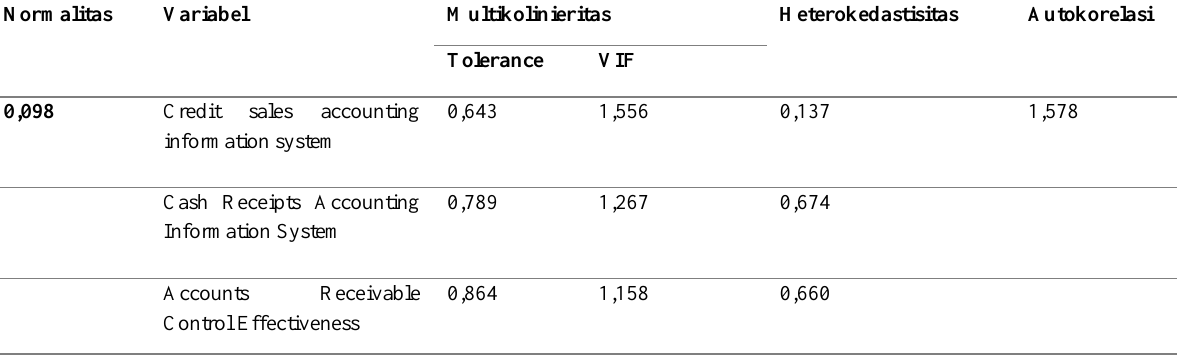
Table 1: Recapitulation of Classical Assumption Test Results